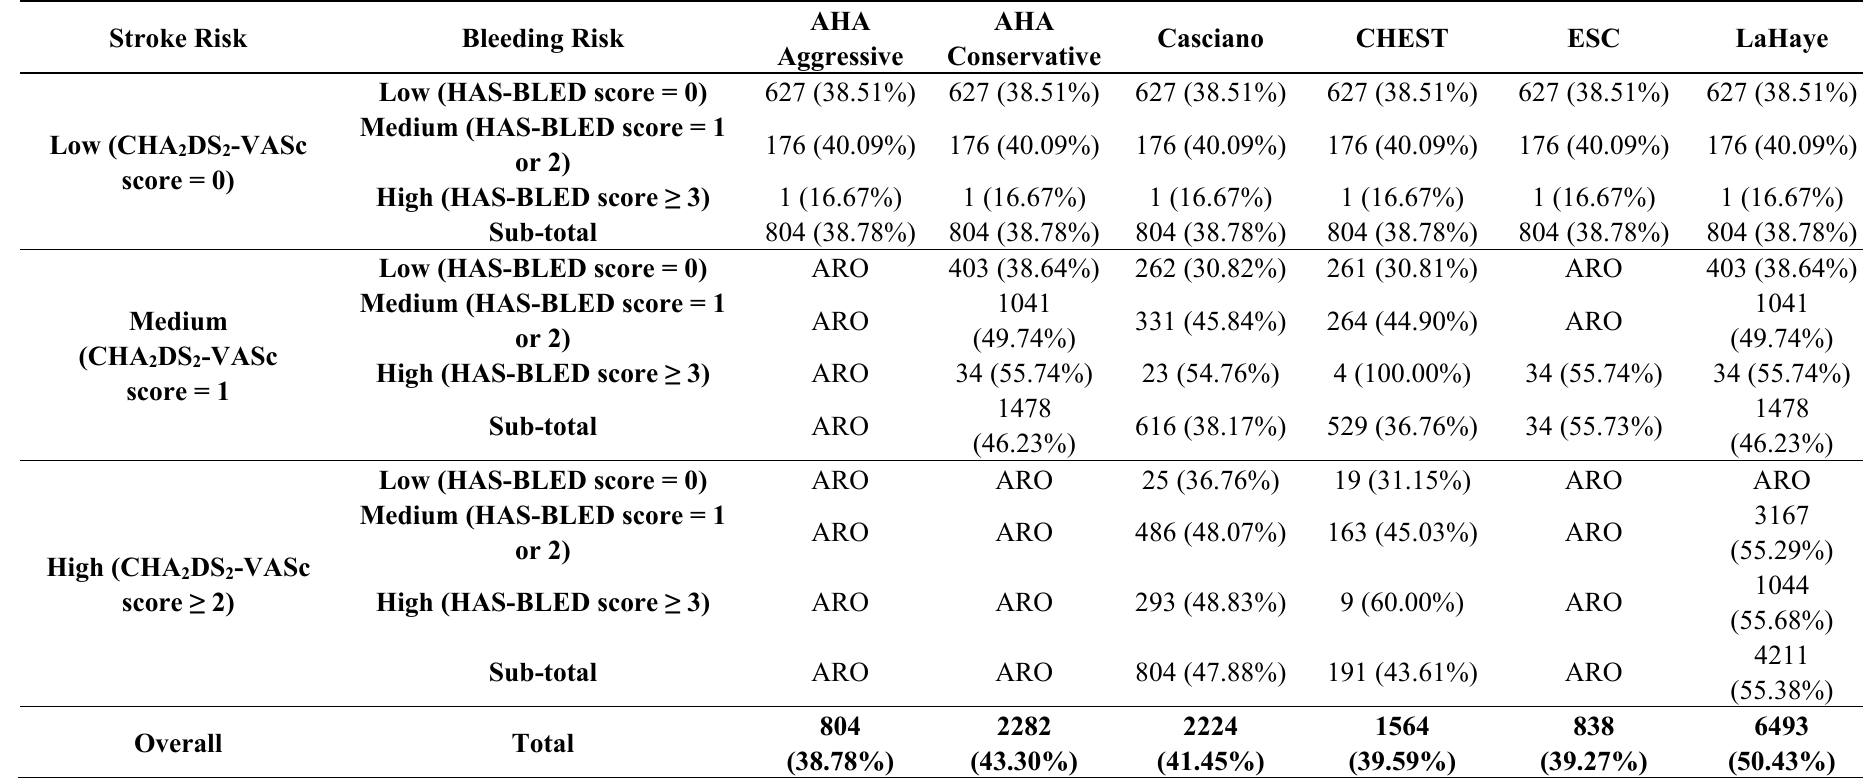
Table 4. Overuse of OAC (Number of patients discordant with the non-OAC treatment recommendation by decision aids). Stroke